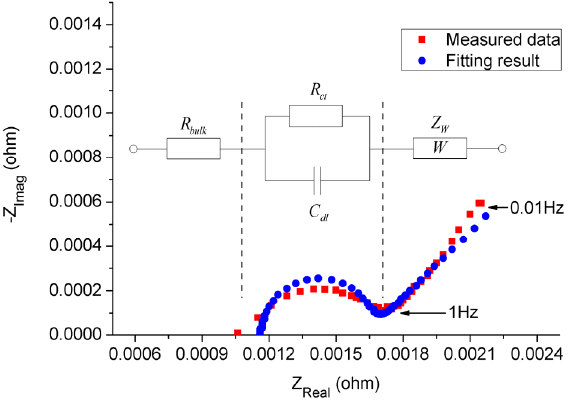
Figure 2. EIS test result and fitting result of the simple EIS